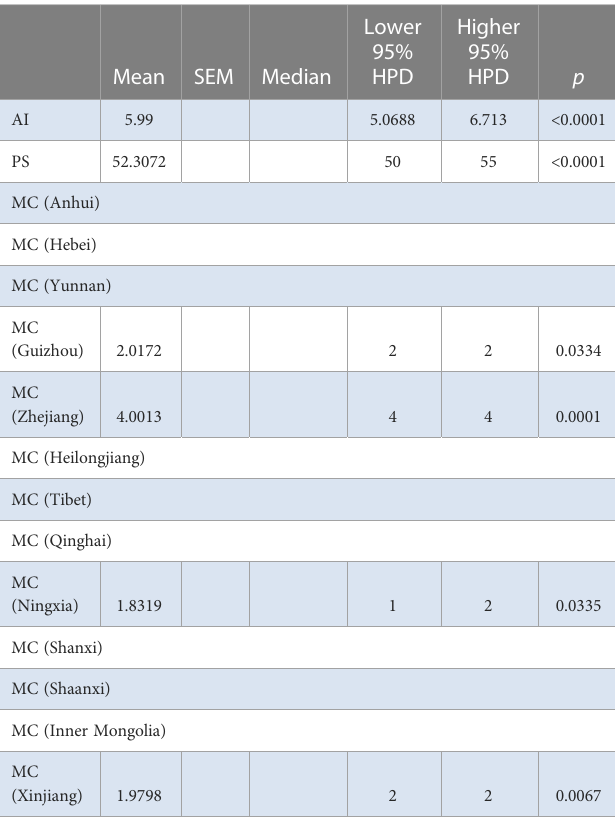
TABLE 2 BaTS algorithm analysis for Chinese AMV population based on geographic locations.